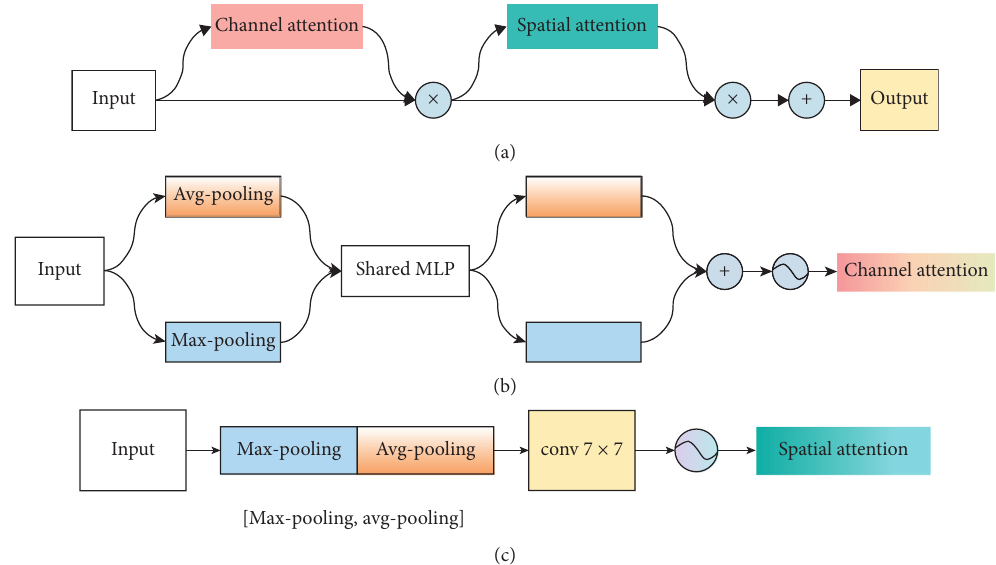
Figure 5: (a) Schematic diagram of the CBAM module structure. (b) Schematic diagram of the channel attention module structure. (c) Schematic diagram of the CBAM module structure.